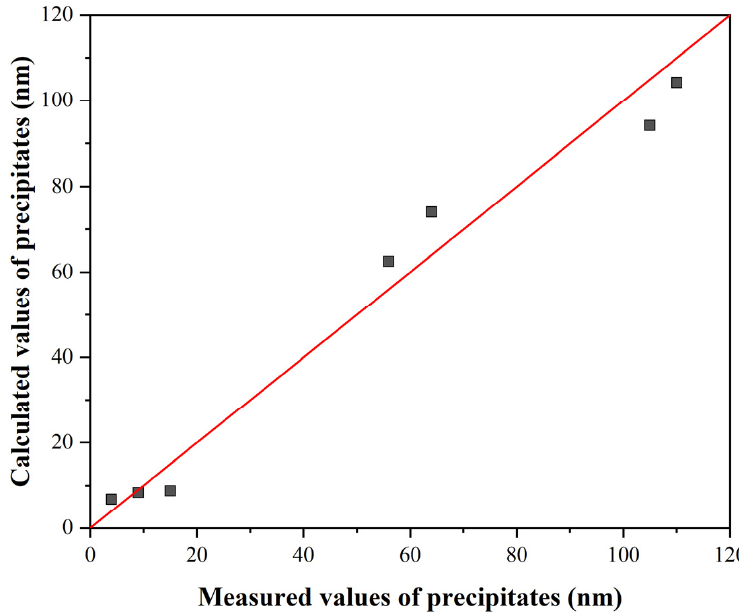
Figure 25. Comparison of measured and calculated values of precipitate size according to Equation (11).